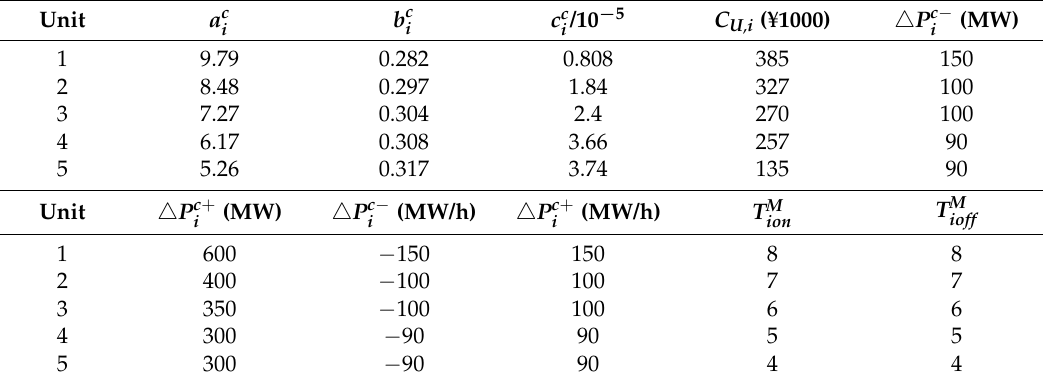
Table 3. Parameters of the five thermoelectric units owned by the thermal power sellers (TPS).